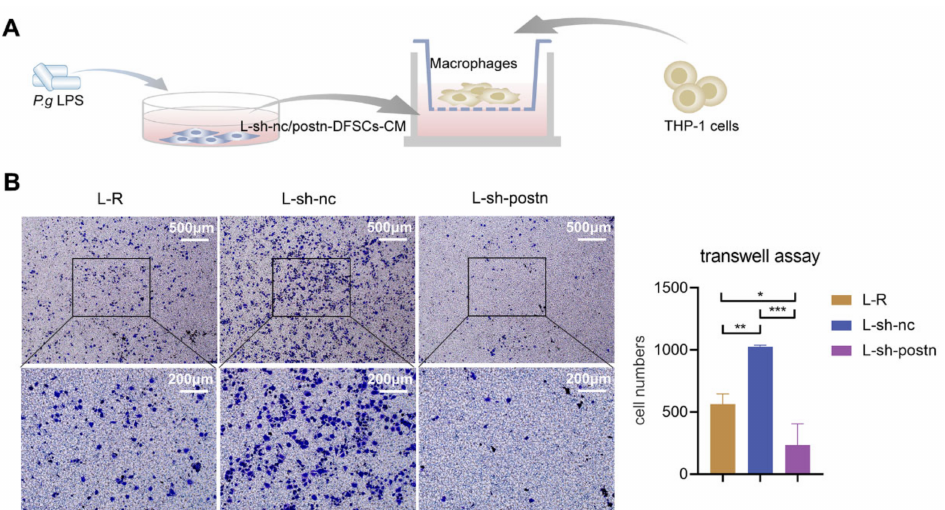
Figure 3. Silencing periostin in DFSCs prevented macrophage migration. ( A ) Schematic diagram to validate the effect of knocking down periostin on DFSC-promoted macrophage migration. ( B ) Rep- resentative images and quantitative analysis of macrophage migration under the DFSCs-CM. The data were analyzed by one-way ANOVA and Bonferroni post hoc test (n = 3). Images were taken at either 4 × (upper row) or 10 × (lower row) magnification. * p < 0.05; ** p < 0.01; *** p < 0.001. Error bars represent means ±